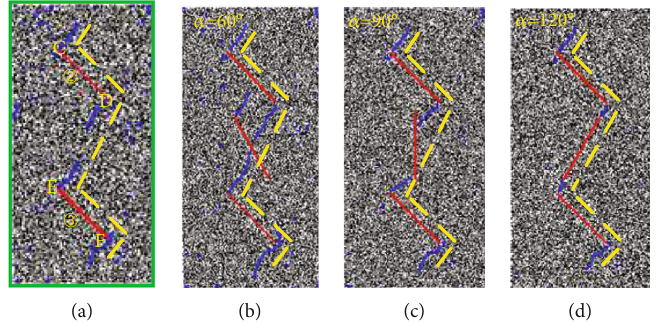
Figure 16: Comparison of the initial crack propagation of double-crack and triple-crack specimens.